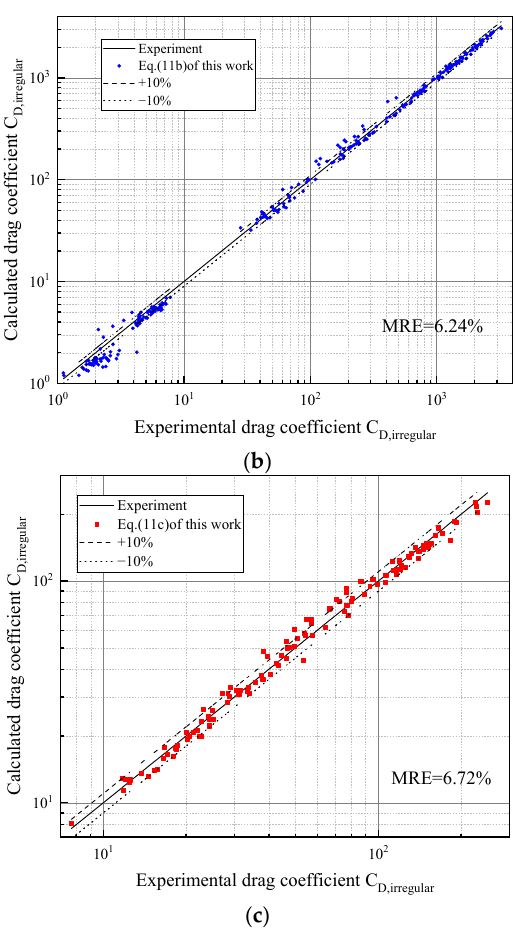
Figure 9. Comparison between anticipated C D value of NSPs and experimental data: ( a ) NF; ( b ) PLF; ( c ) HBF.